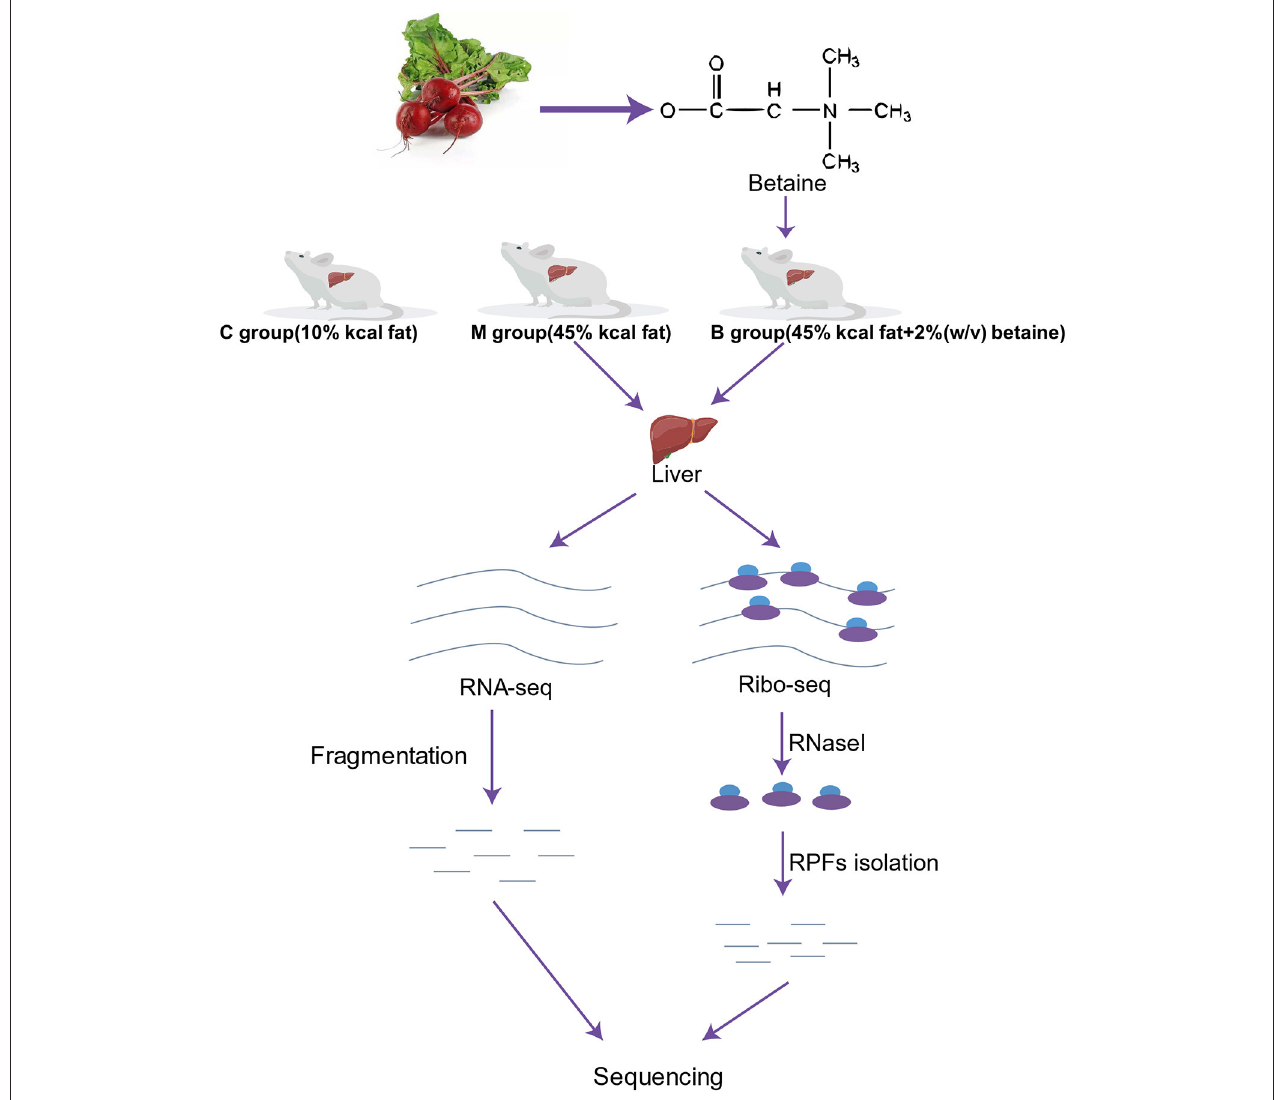
FIGURE 1 | Workflow of the study design and high-throughput sequencing. C, control group; M, model group; B, betaine